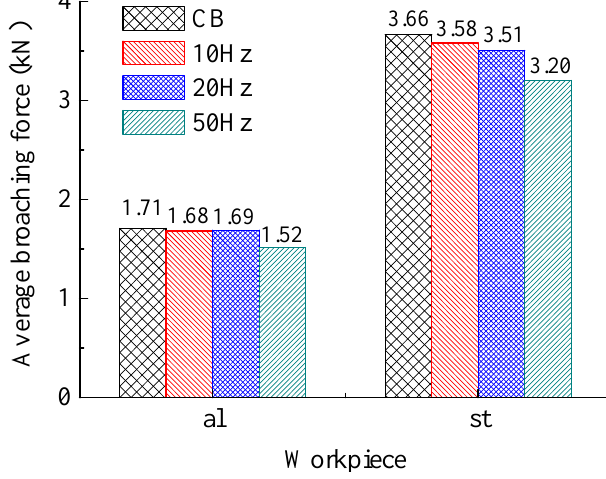
Figure 7. Average broaching forces of section A.